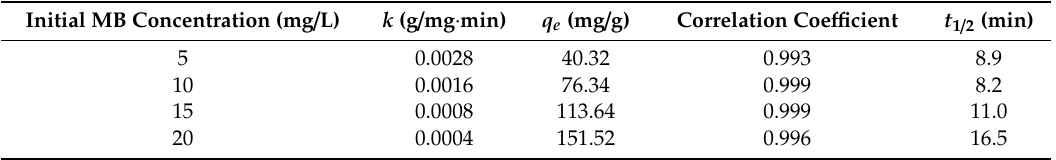
Table 3. Kinetic parameters for methylene blue (MB) adsorption onto adsorbent CM-AC-700 at initial MB concentrations based on pseudo-second order model a